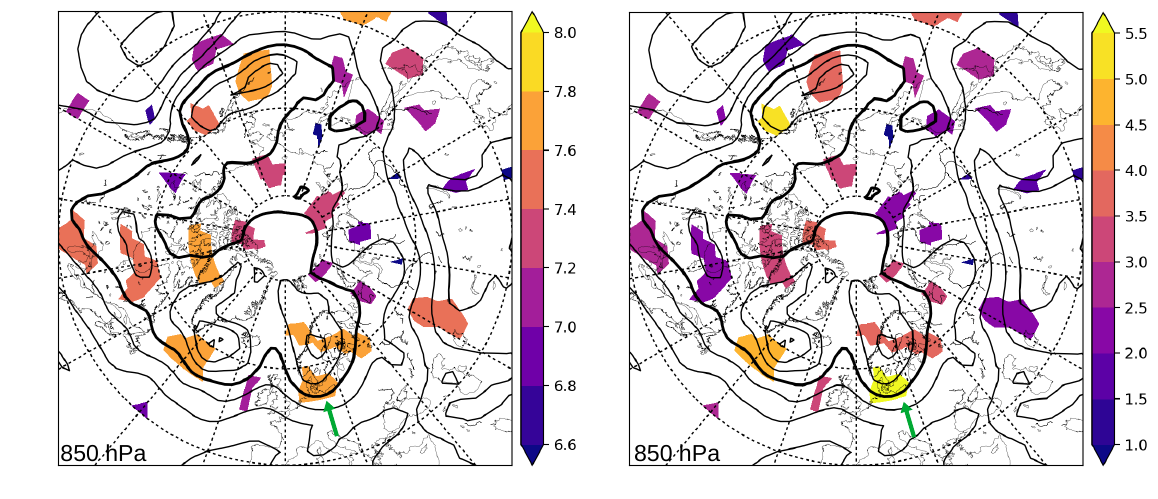
Figure 6. In NCEP data, identified cyclonically-rotating vortices in the Northern Hemisphere on 18 January 2007 18UTC at 850hPa. ( a ) Color shading indicates the magnitude of the circulation Γ of the systems; ( b ) color shading corresponds to the mean vorticity ζ averaged over the identified vortex areas (estimated by Γ = ζ A ). Black contours: geopotential height in 80-m intervals; the thick black line corresponds to the 1440-m contour, while the green arrow points to